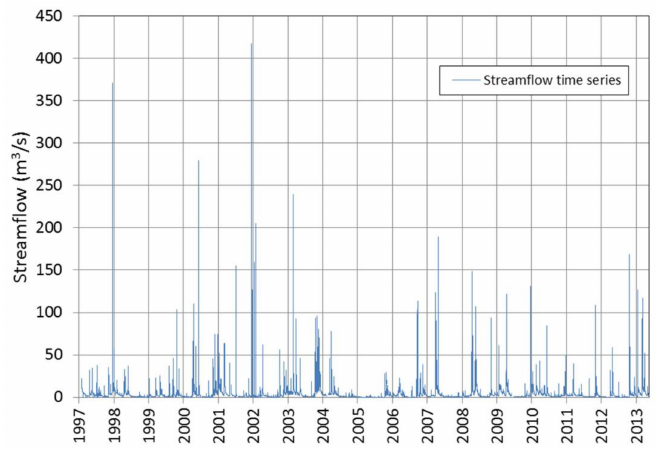
Figure 1. Time series of the A033 stream gauge of the Alcanadre